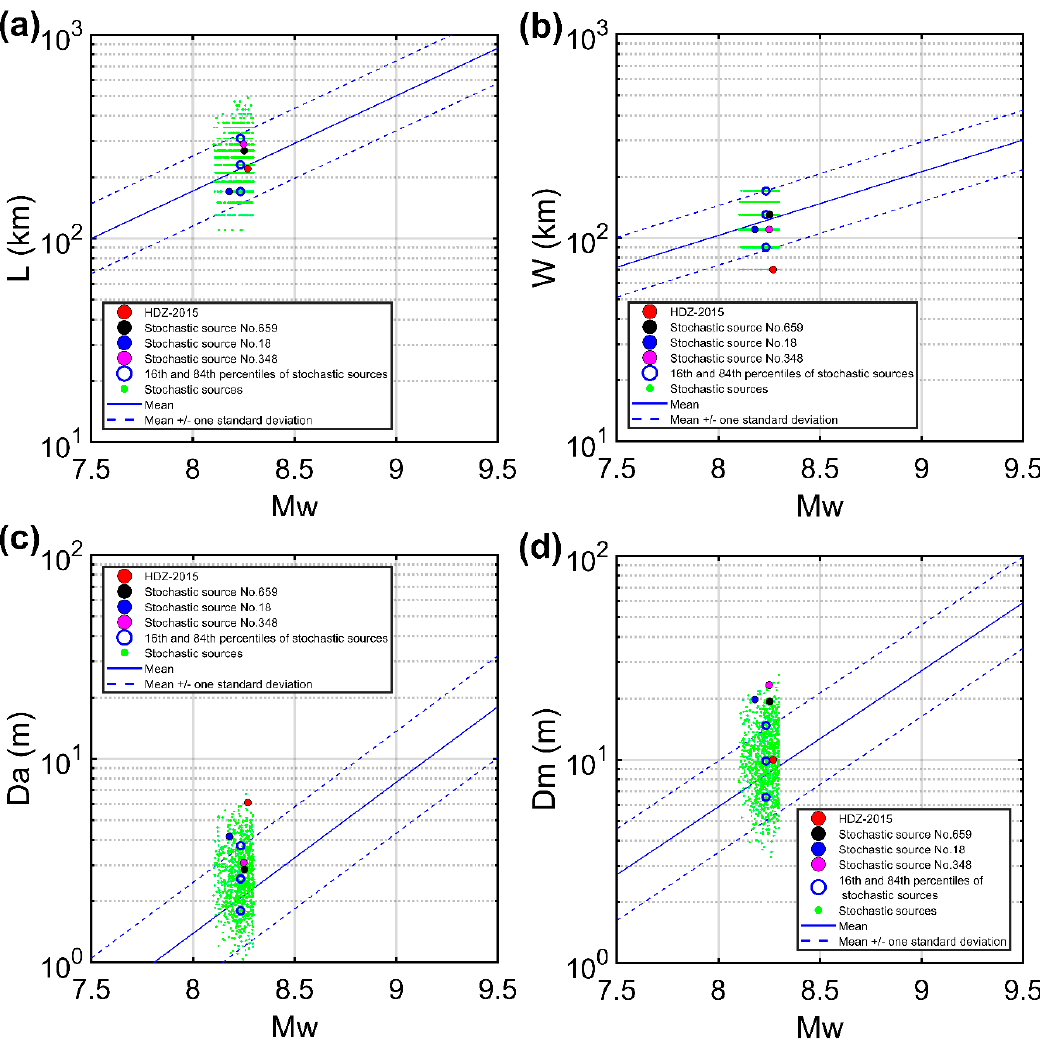
Figure 7. Comparison of 1000 stochastic source parameters (green dots) and parameters of the HDZ-2015 model with the corresponding scaling relationships for ( a ) fault length L , ( b ) fault width W , ( c ) mean slip D a , and ( d ) maximum slip D m.